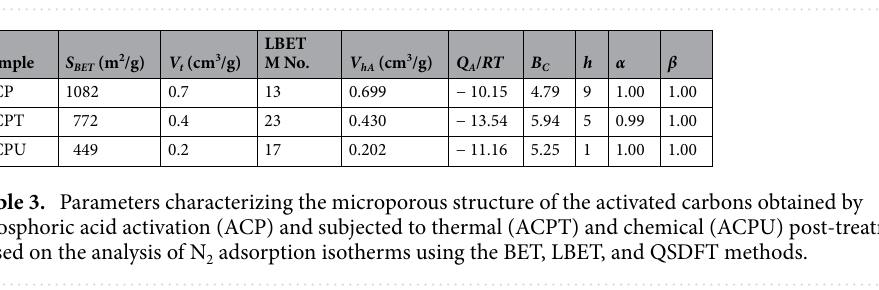
Figure 9. SEM images of Pine cones (PC) at different magnifications: PC1 (× 500), PC2 (× 1000) and PC3 (× 2500), and of the activated carbons (× 500) developed with different impregnation ratios and activation temperatures.